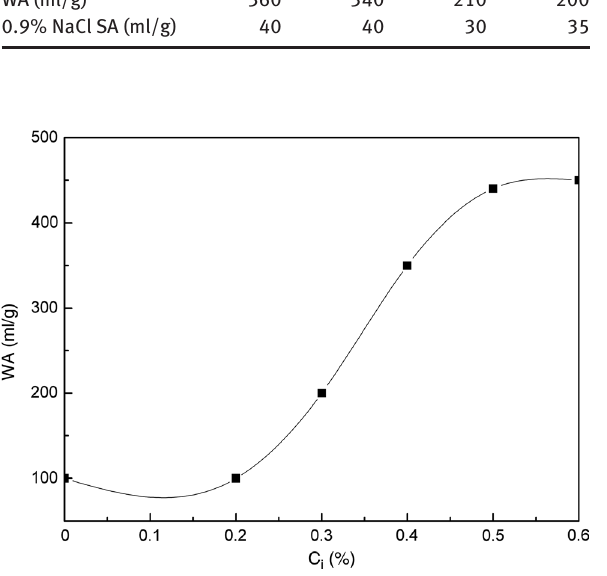
Figure 3 Effect of PVA content on temperature tolerant/WA